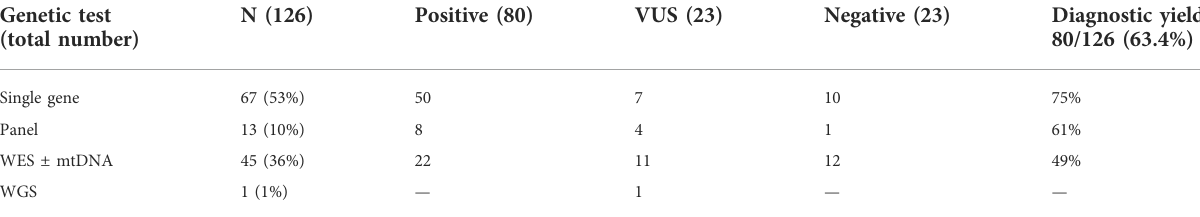
TABLE 4 Diagnostic yield of each gene test type in a cohort of 126 patients. Genetic test (total